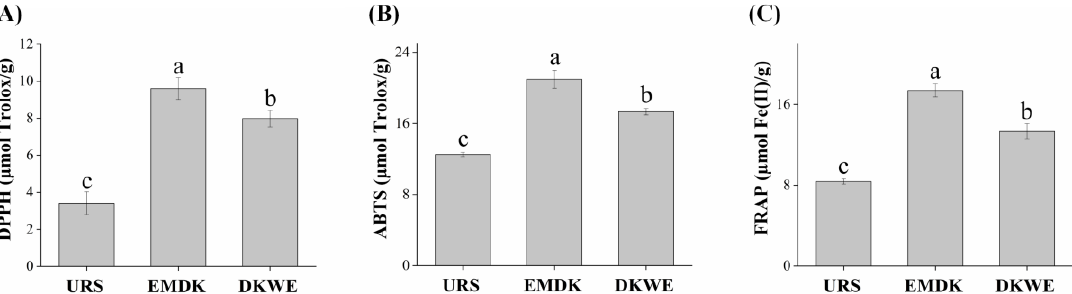
Figure 6. The antioxidant capacities of different samples. ( A ) The DPPH radical scavenging capacity; ( B ) The ABTS radical scavenging capacity; ( C ) The ferric-reducing antioxidant power (FRAP). Abbreviations: URS, unfermented raw samples; EMDK, edible mushroom by-product Douchi koji; DKWE, Douchi koji without edible mushroom by-product. Values are expressed as the mean ± the SD (n = 3). Bars with different lowercase letters represent significant differences ( p < 0.05).